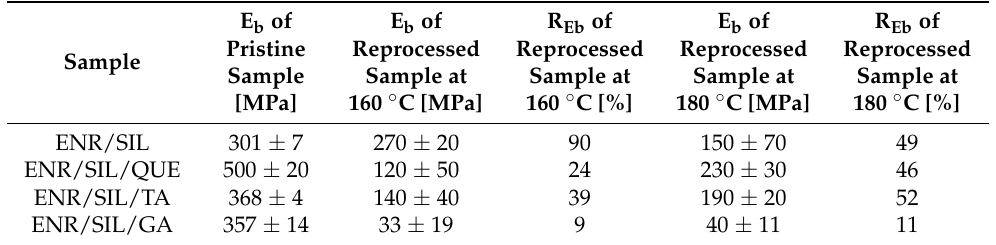
Table 2. Elongation at break (Eb) results of ENR/silica composites with natural phenolic com-pounds before and after reprocessing at 160 ◦ C and 180 ◦ C with effectiveness of reprocessing calculated using elongation at break results (R Eb (%)).